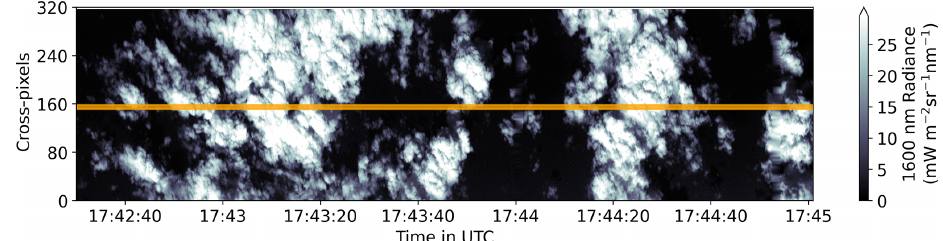
Figure 9. Cloud scene containing two clouds largely extending over the entire imager FOV. Radiances from imager 1600nm channel. The radar transect is shown in